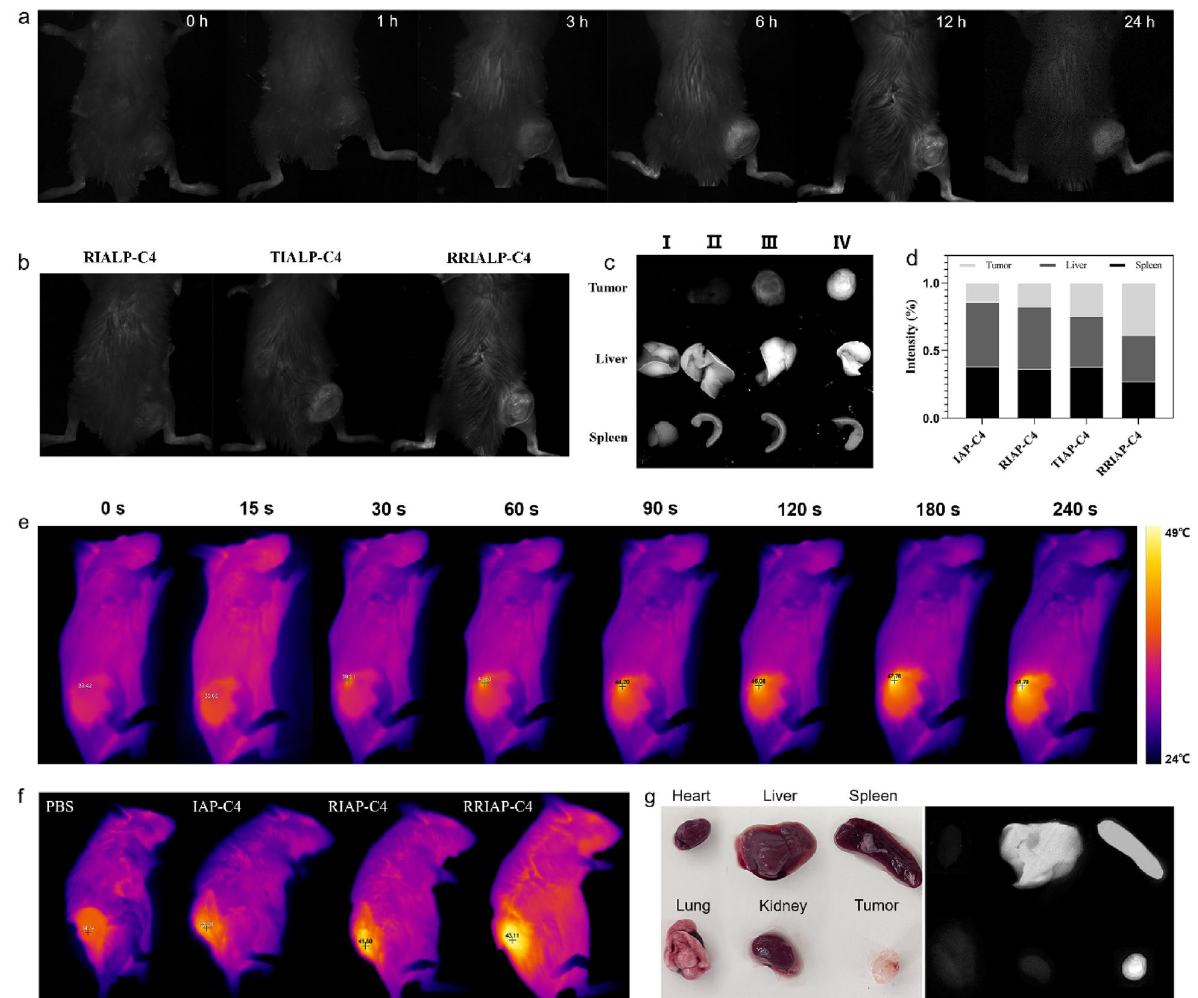
Fig. 7 In vivo NIR-II FI and PTI of RRIALP-C4. a In vivo NIR-II FI of RRIALP-C4 at different time points (0, 1, 3, 6, 12, 24 h). b In vivo NIR-II FI of different liposomes after projection for 12 h. c , d Fluorescence intensities of different liposomes in liver, spleen, and tumor after projection for 12 h. I: IALP-C4. II: RIALP-C4. III: TIALP-C4. IV: RRIALP-C4. e In vivo PTI of RRIALP-C4 at different time points (0, 15, 30, 60, 90, 120, 180, 240 s). f In vivo PTI of different liposomes after irradiation for 240 s. g Distributions of RRIAP-C4 in different organs after treatment for 24